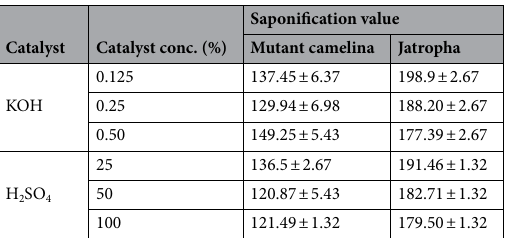
Table 7. Saponification values (mg KOH/1 g) of biodiesel from mutant camelina and jatropha.